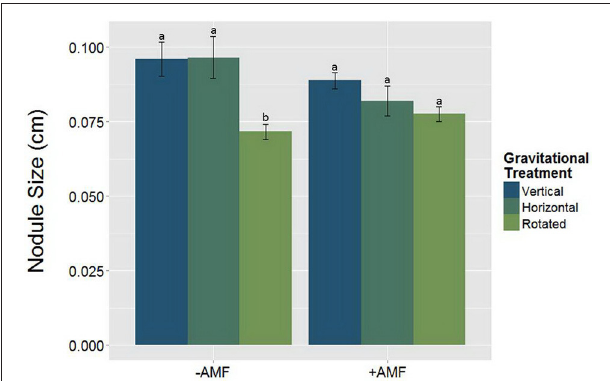
FIGURE 7 | The interaction between AMF x gravitational treatment in nodulated plants ( n = 71 ). Nodule size is significantly smaller ( p < 0.05 ) under rhizobia + clinorotated ( n = 15 ) treatments compared to the static controls. The letters above each standard error bar denote significance between AMF treatments.